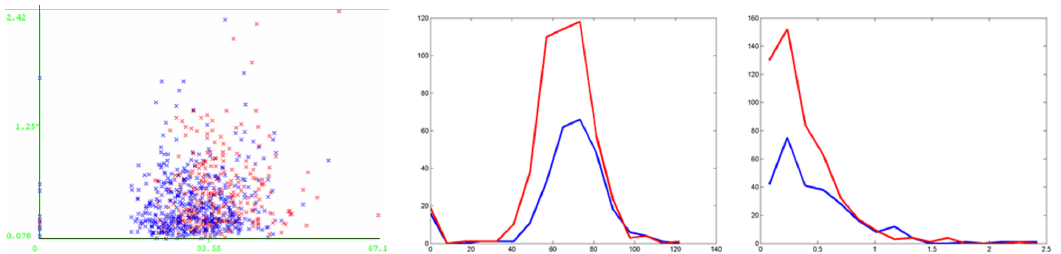
Figure A7. Scatter and Histogram of Pima